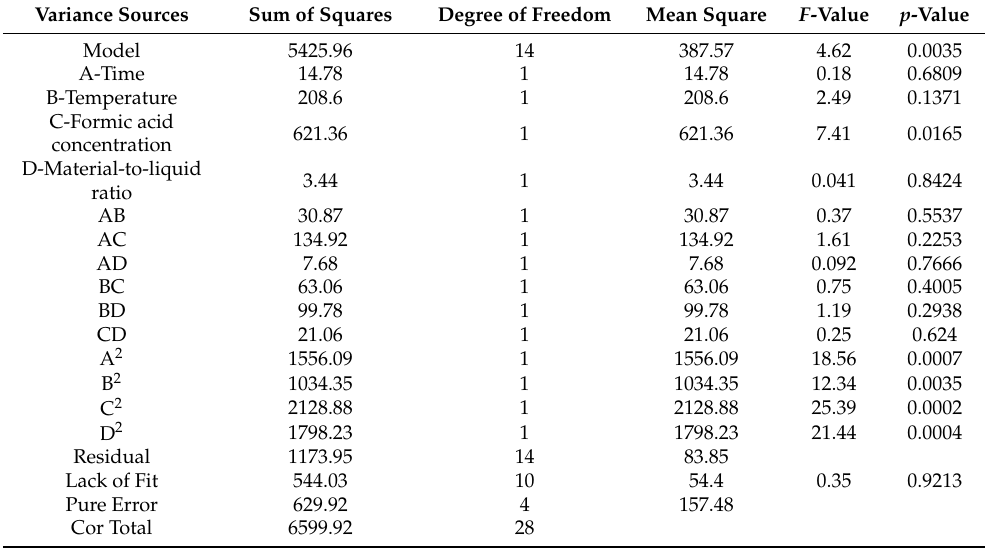
Table 4. Variance analysis of quadratics simulation of response surface.